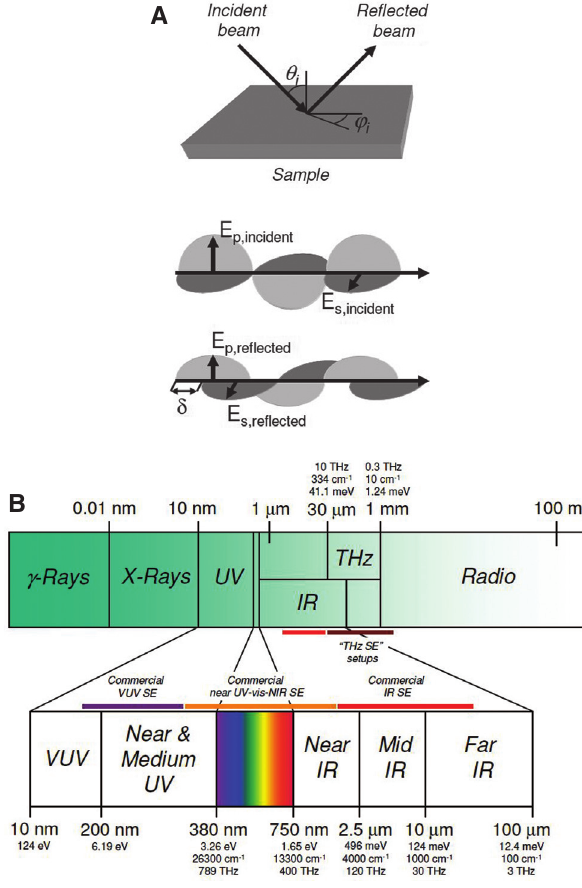
Figure 1 Ellipsometry and its spectral range. (A) Schematic repre- sentation of a typical spectroscopic ellipsometry configuration (in reflection); the angle of incidence θ and azimuth ϕ are depicted, i i as well as the phase shift δ between the s- and p-components of the electromagnetic wave induced by reflection on the substrate. The plane of incidence is the plane of the paper (B). Schematic representation of the electromagnetic spectrum, together with the typical spectral ranges accessible using the different types of spec- troscopic ellipsometry